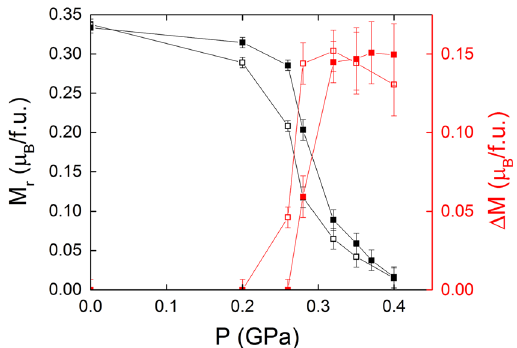
Fig. 5 Magnetization at 5 K of a UCo 0.990 Ru 0.010 Al single crystal at selected hydrostatic pressures in a magnetic fi eld applied along the c -axis. Obtained data were cut in order to properly visualize both coercivity and metamagnetism at once